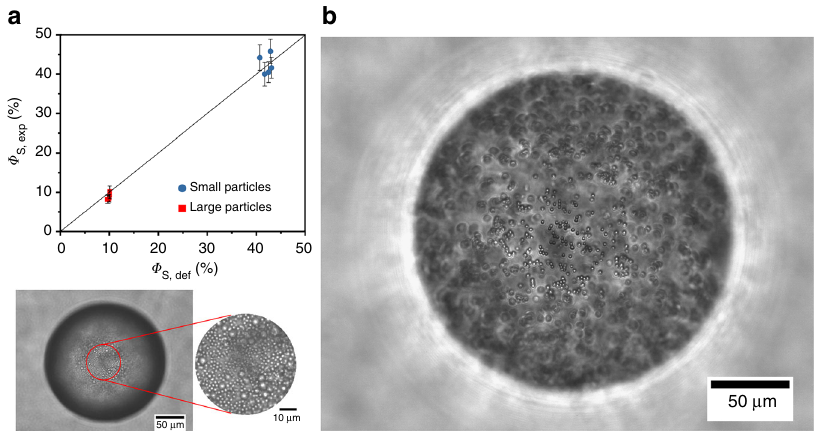
Fig. 4 Control over composition. a Micrograph of emulsion droplet with a predetermined mixture of large and small silica particles, quanti fi ed using image analysis. b Composite emulsion droplets stabilised using a combination of hydrophobic silica spheres and hydrophylic rodlike imogolite particles, this image was taken after the miscible liquid had dissolved and a multilayer was